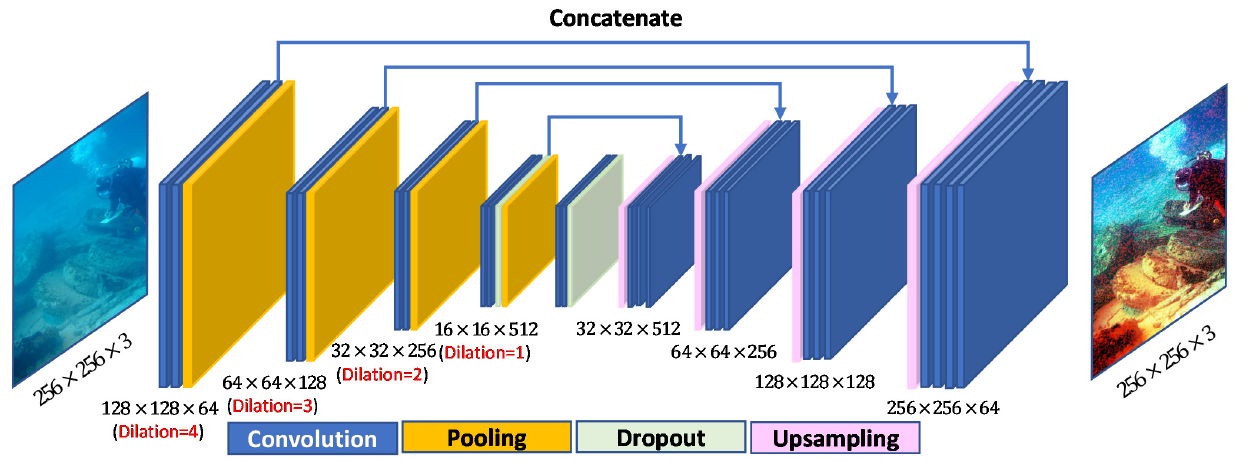
Figure 2. Generator architecture of proposed DGAN.